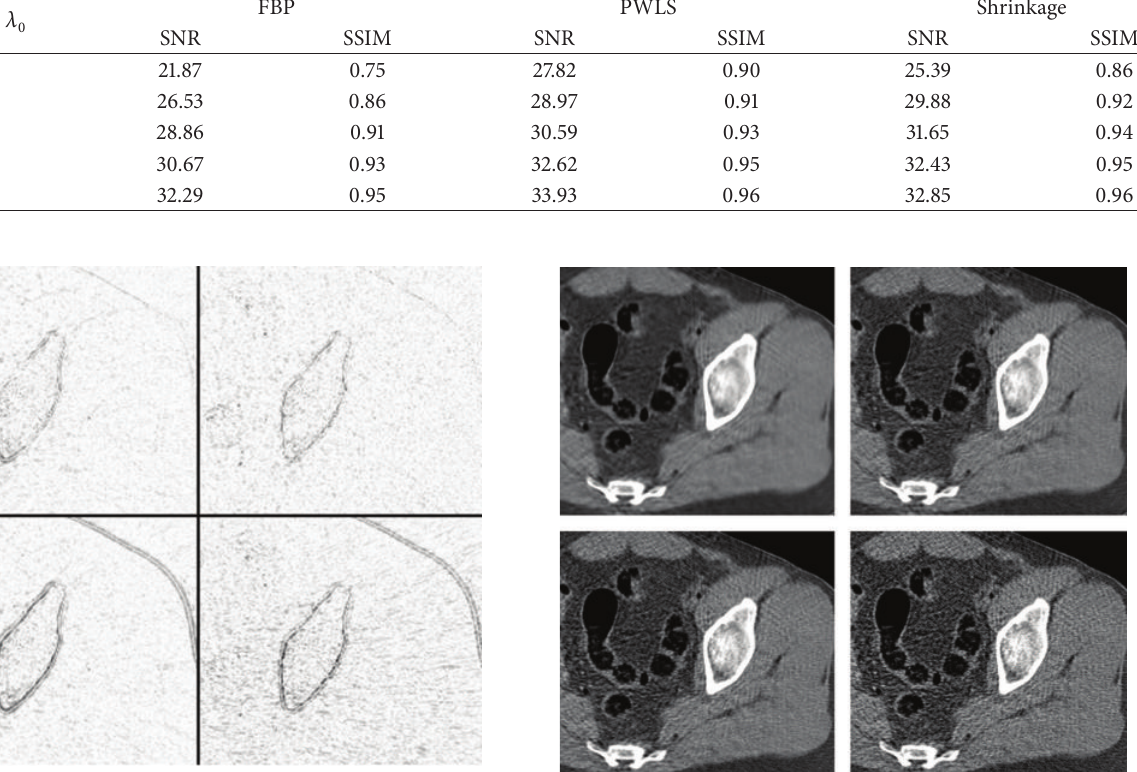
Figure 19: Reconstruction with learned shrinkage trained with the different values of the weight 𝜇 . Upper to lower rows, left to right: images corresponding to 𝜇 = [14.3, 105.6, 205.5, 400]